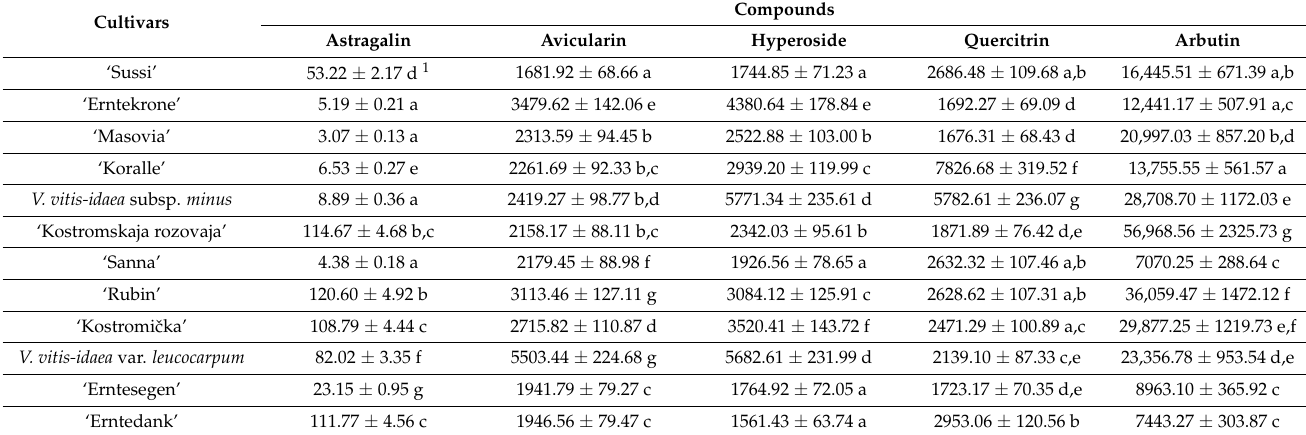
Table 1. Contents of flavonols and simple phenols ( µ g/g DW) of Lingonberry leaves